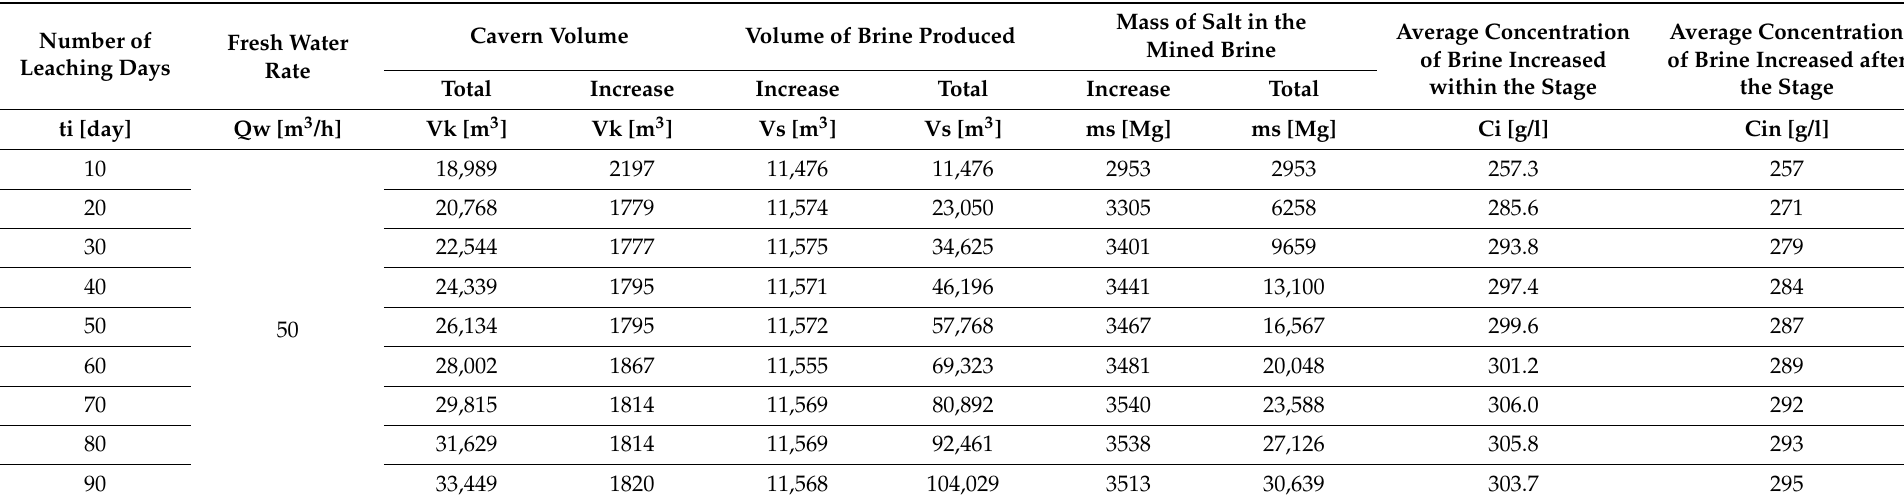
Table 9. Development of Phase I of stage II leaching process after cutting 4 niches (R1 R4 = 5 m)—Stage II/Scenario 2 (S II/S